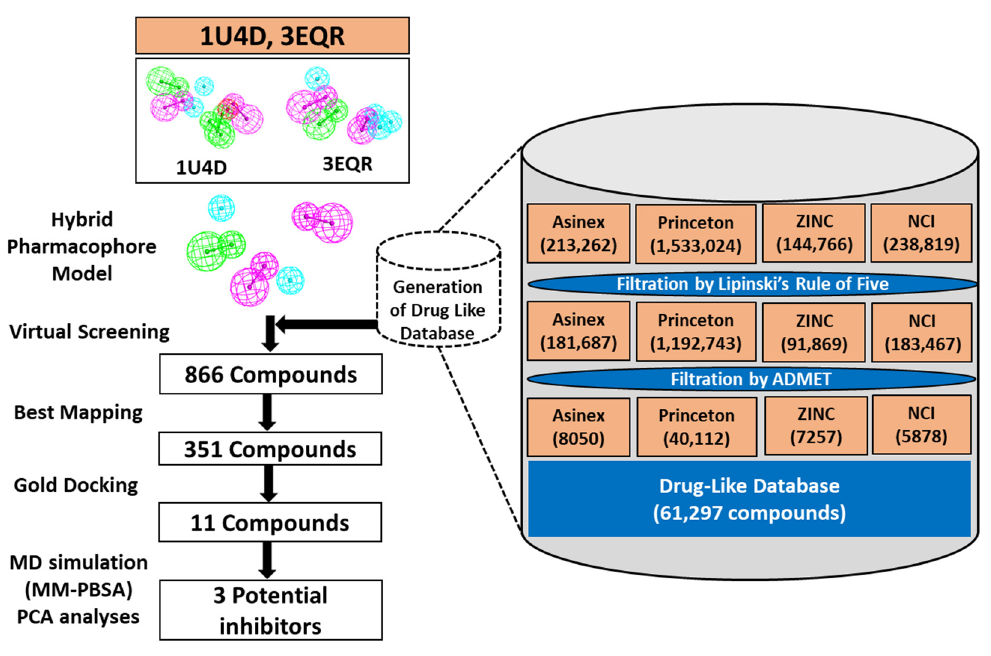
Figure 2. The workflow used in this study for the identification of potential ACK1 inhibitors. Gen- eration of pharmacophores from two different structures. The drug-like database generation step is shown on the right